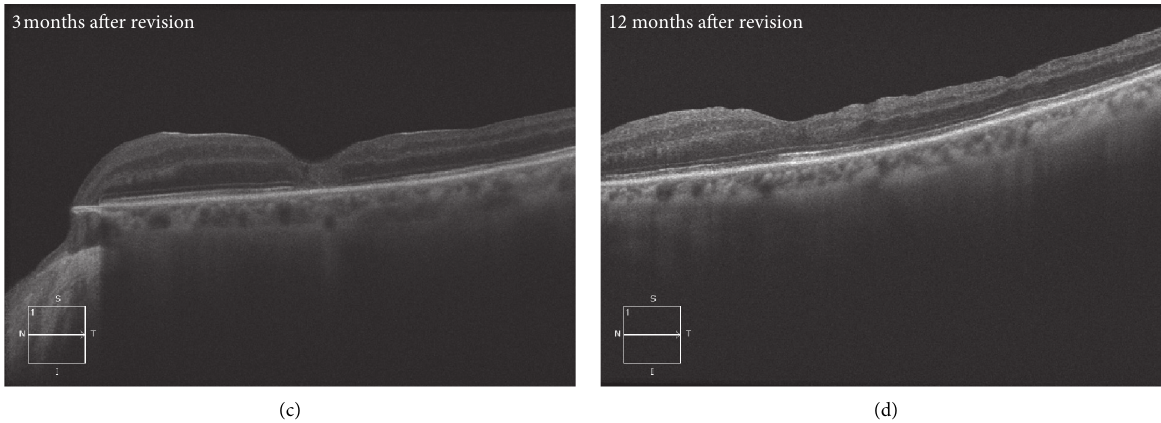
Figure 2: Preoperative and postoperative OCTscans. (a) Preoperative OCTscan of an eye with a VA of 41 letters (6/45). (b) OCTscan of an eye prerevision surgery with a VA of hand motion. (c-d) OCTscans 3 and 12 months after successful revision surgery with a VA of counting fingers for